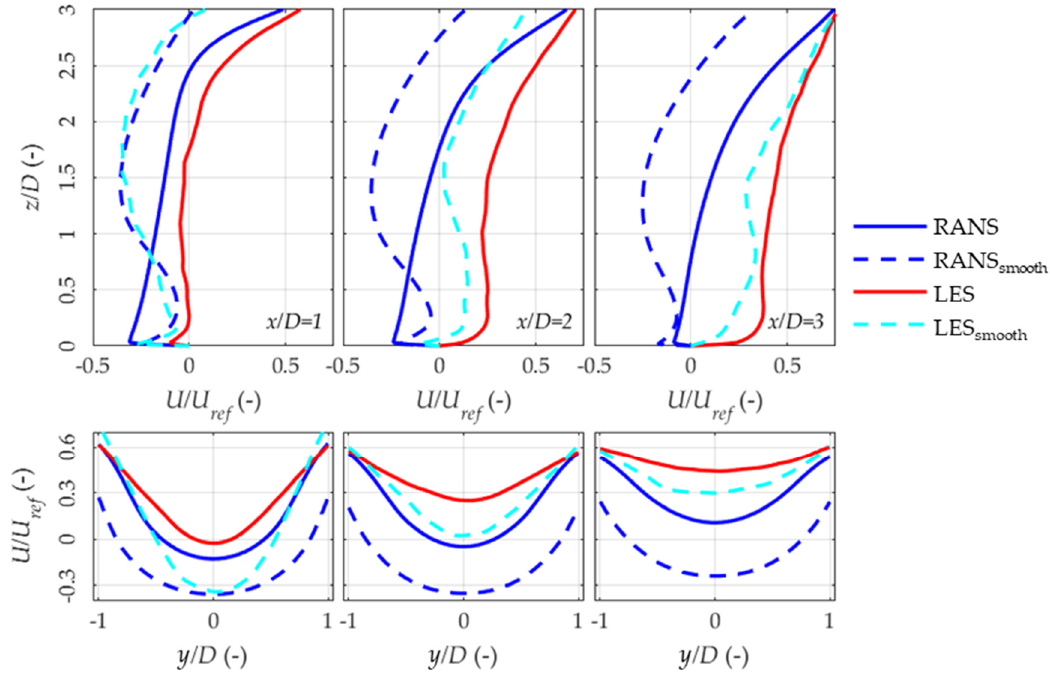
Figure 18. Prediction of the mean longitudinal wind speed distribution in the wake region. Profiles refer to three distances from the downstream side of the building, namely, x / D = 1, 2, and 3.